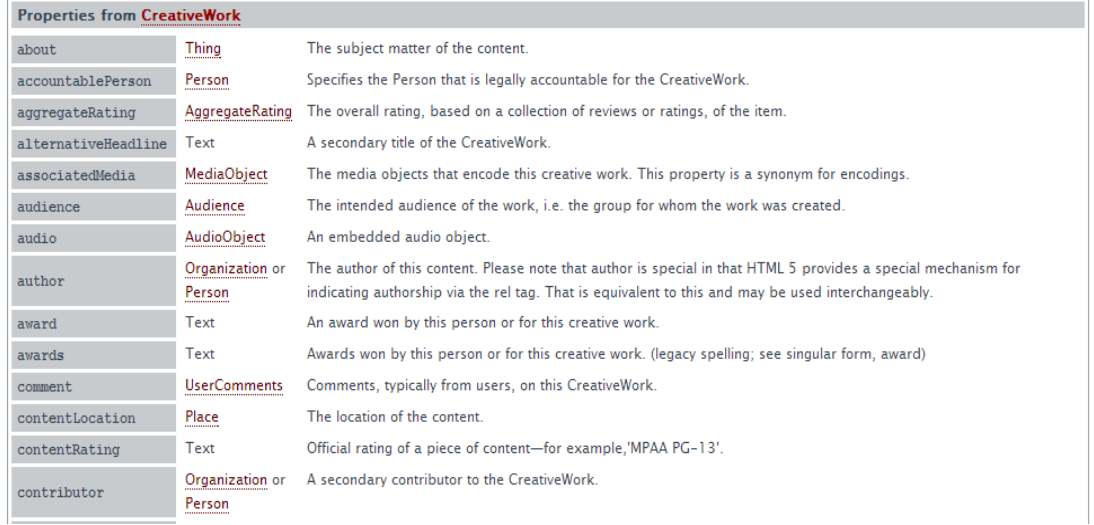
Figure 3. Schema